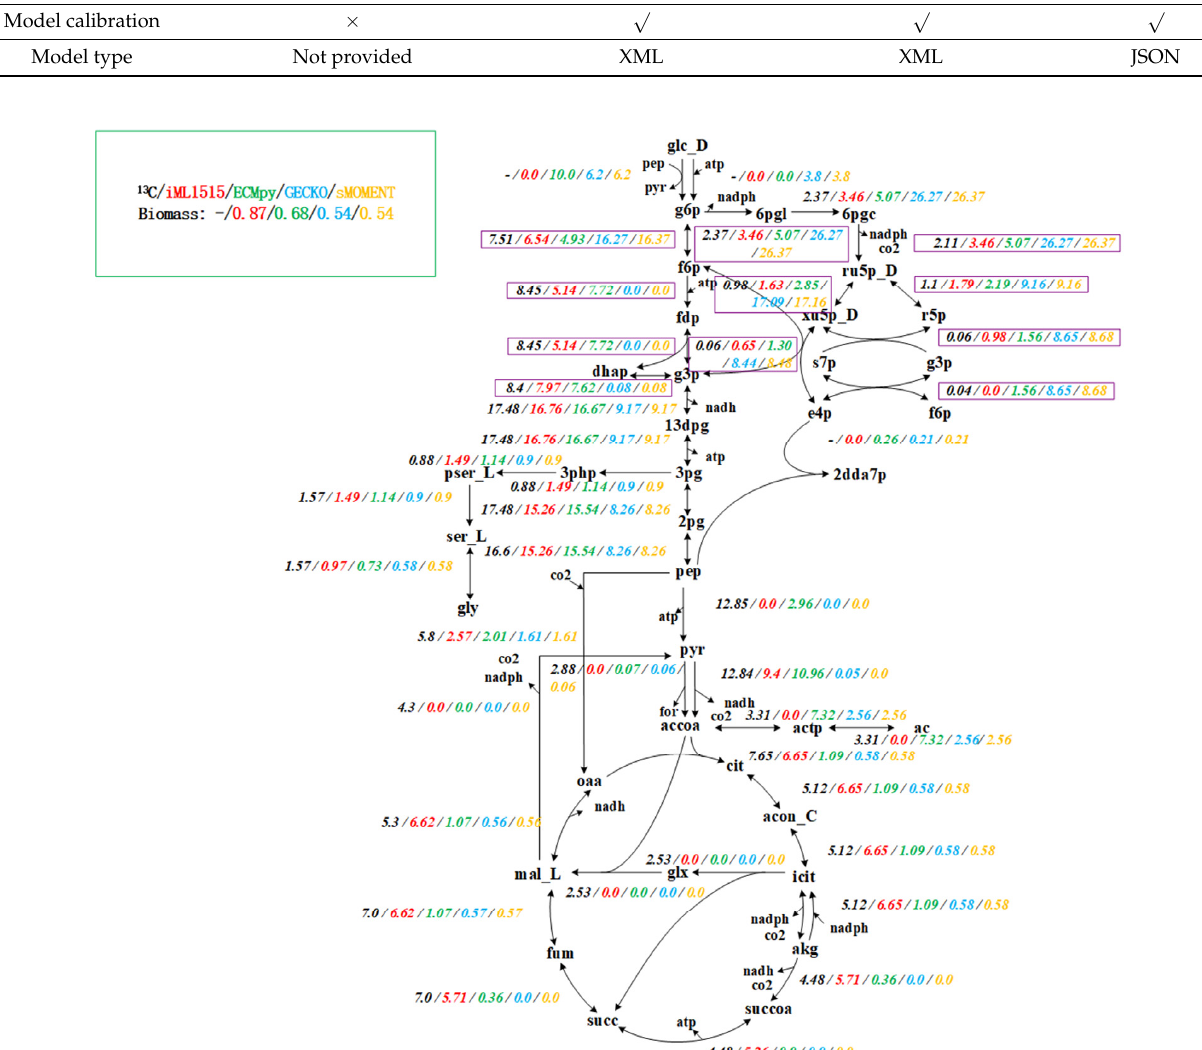
Figure 2. Flux Comparison of i ML1515, ECMpy, GECKO and sMOMENT. From left to right: 13 C experimental data (black), prediction results of i ML1515 model (red), prediction results of ec i ML1515 constructed by ECMpy (green), prediction results of ec i ML1515 constructed by GECKO (blue), and prediction results of ec i ML1515 constructed by sMOMENT (yelllow).